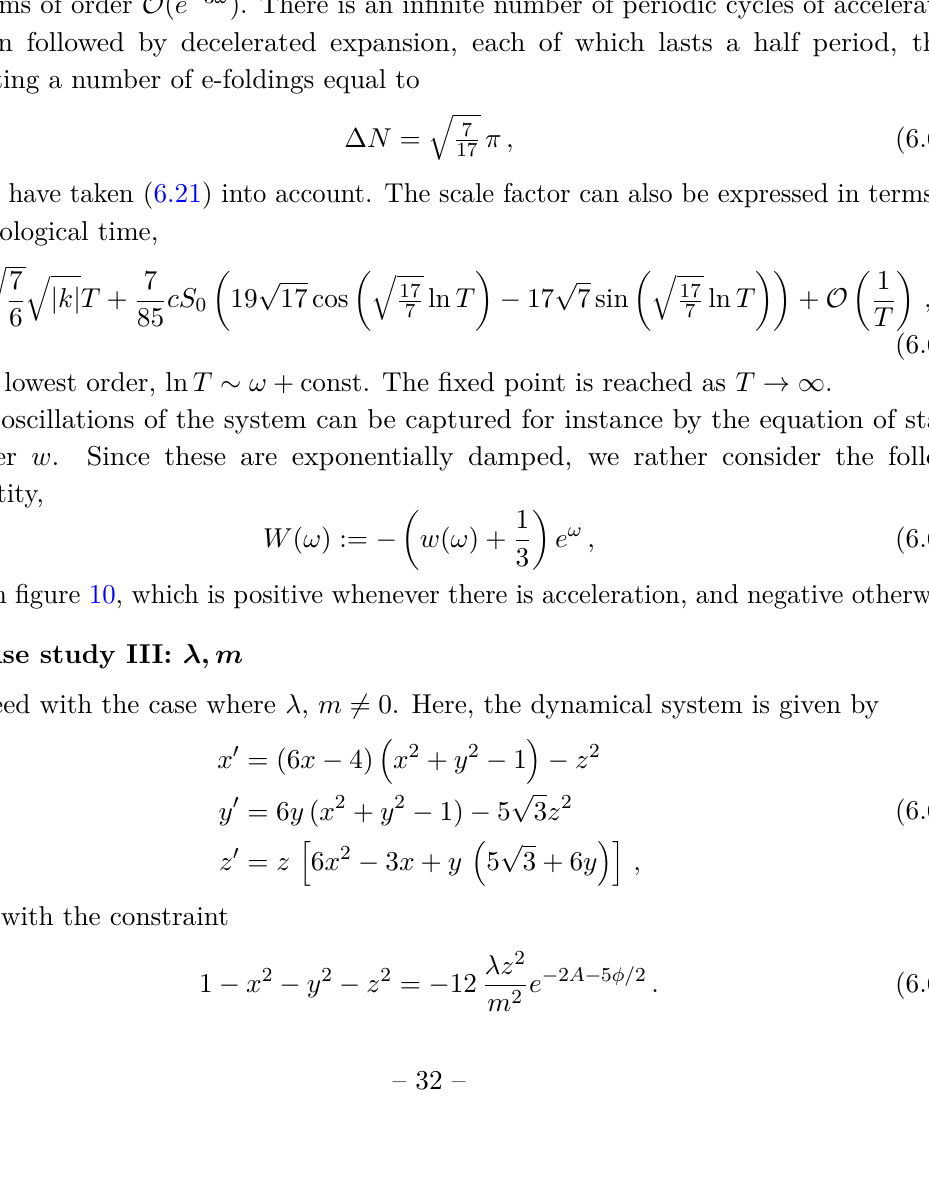
Figure 10 . Plot of W as a function of ω , as defined in (6.64). (Half-) periods of acceleration correspond to W > 0 . As ω increases, the duration of these accelerated periods tends to the variable ω